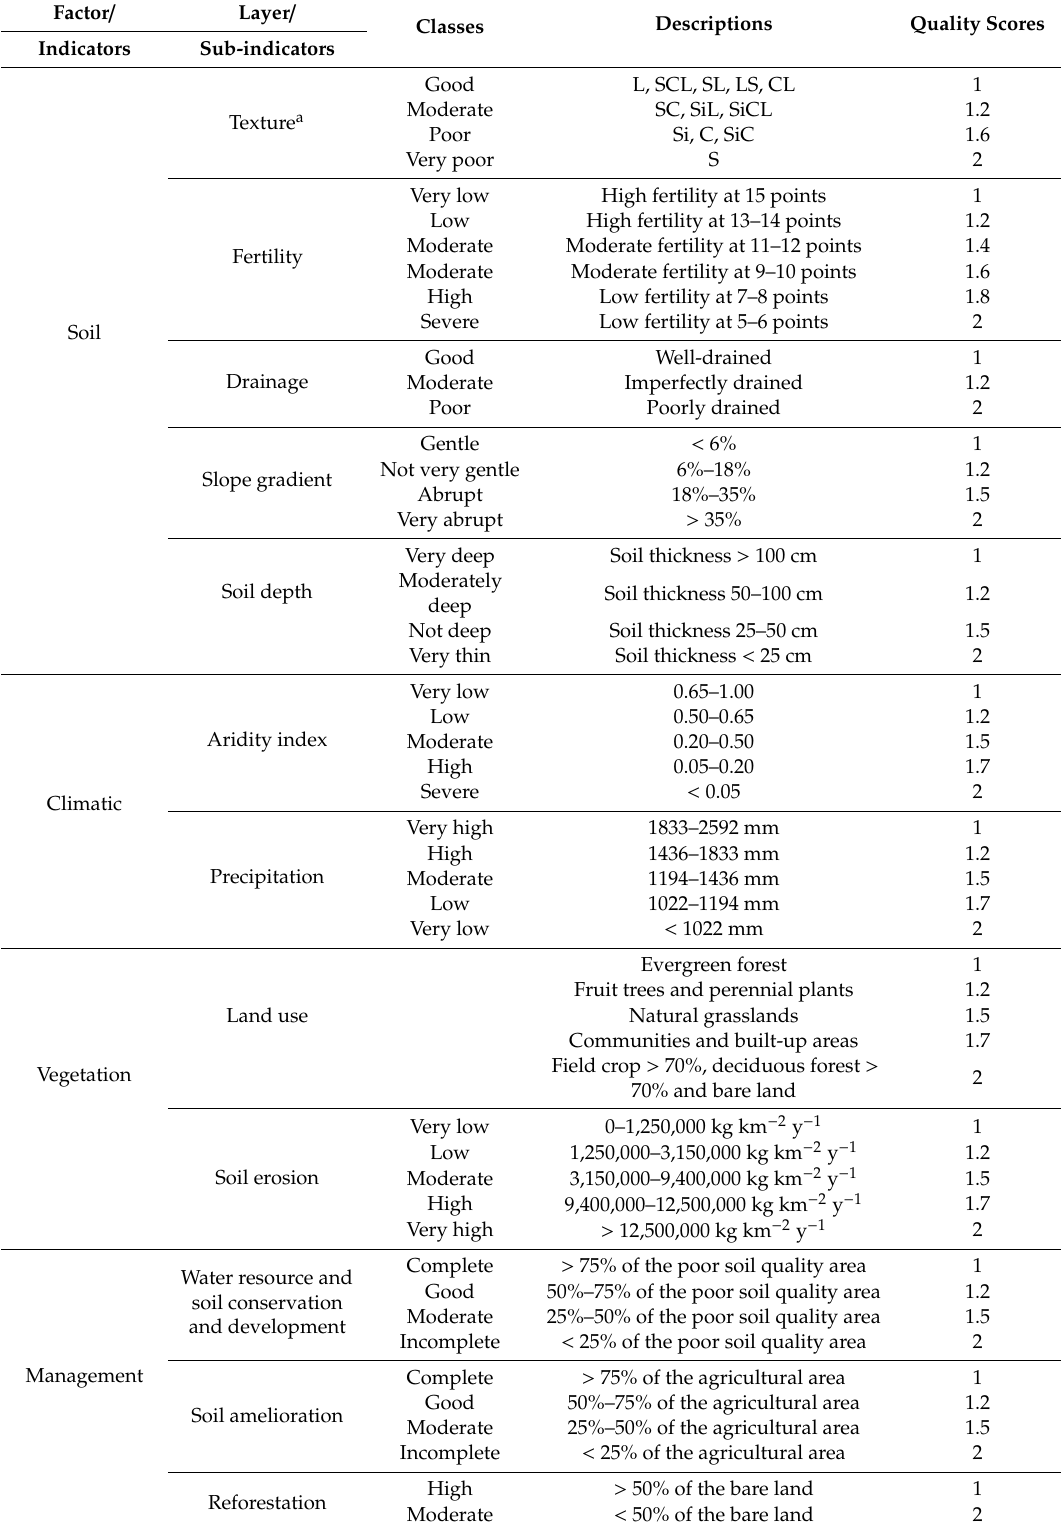
Table 1. Classes and assigned weighting index for